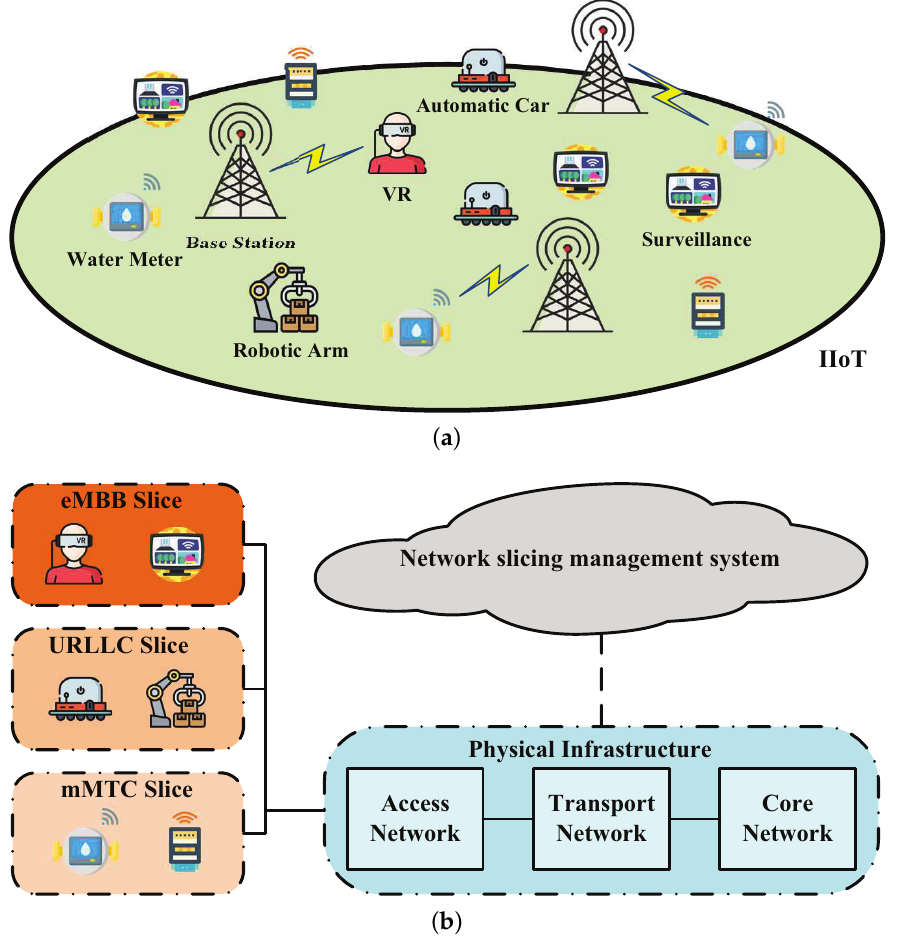
Figure 1. The system model of network slicing. ( a ) Example of wireless IIoT; ( b ) the architecture of network